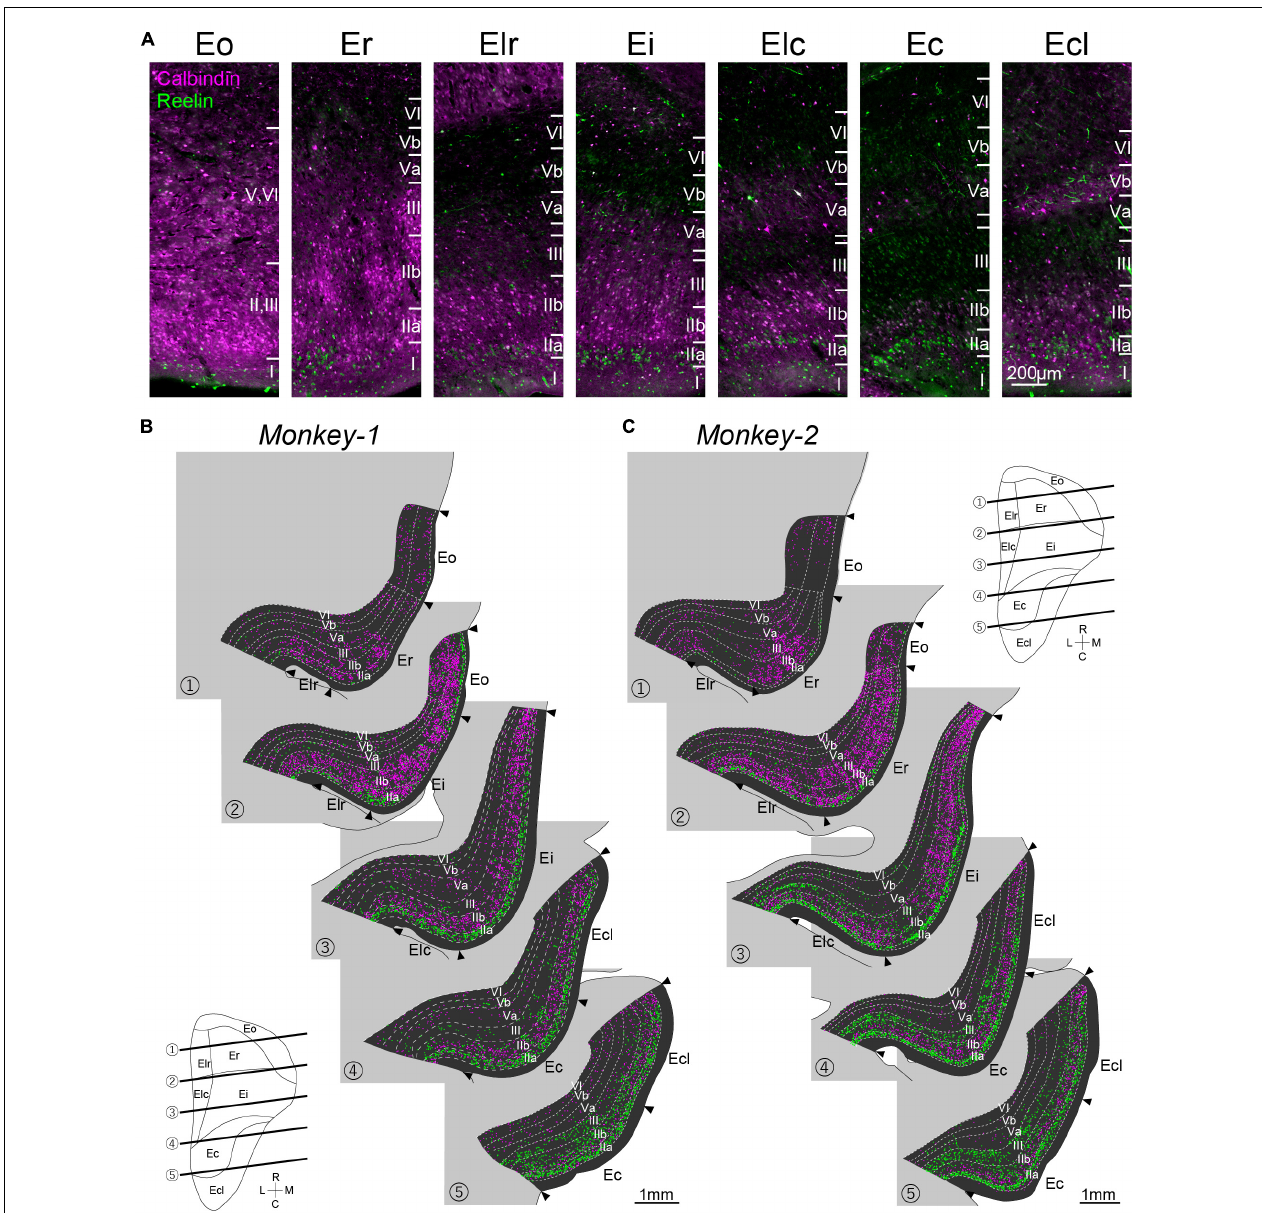
FIGURE 4 | Distribution of CB + and RE + neurons in monkey EC. (A) Fluorescent images of CB + neurons (magenta) and RE + neurons (green) in EC subdivisions. (B,C) Series of coronal sections of EC showing the distribution of CB + neurons (magenta) and RE + neurons (green) in Monkey-1 (B) and Monkey-2 (C) . NeuN-labeling was used to delineate the individual layers and the EC subdivision. The approximate rostrocaudal levels of the sections are indicated in the unfolded map of